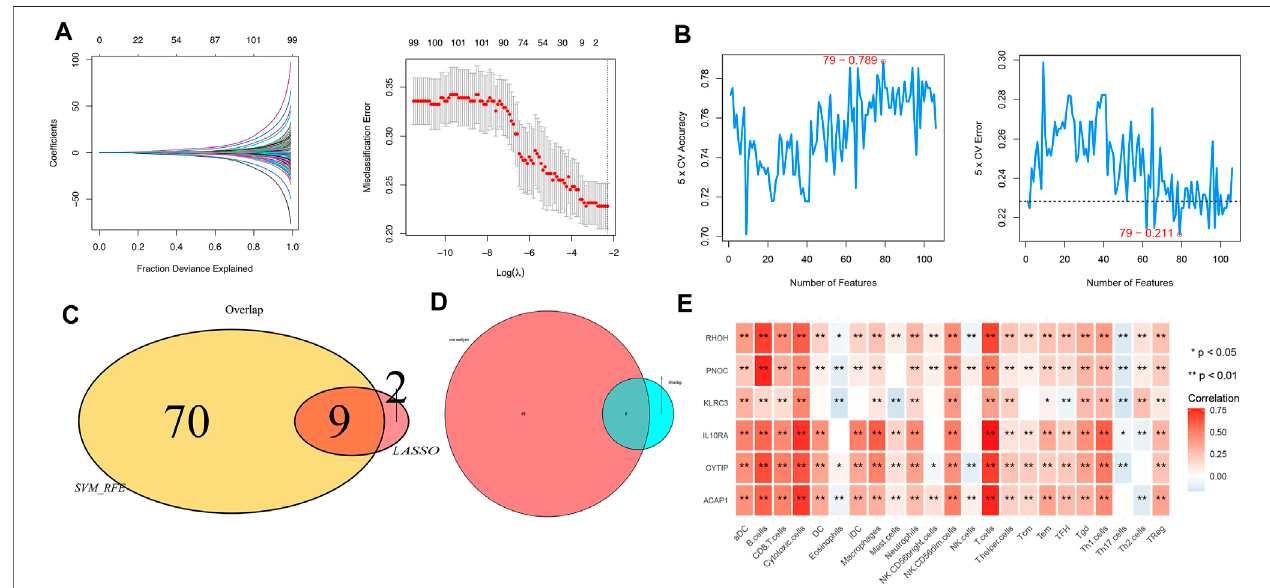
FIGURE 5 | (A) LASSO and (B) SVM-RFE algorithms in the detection cohort. (C) Overlap of incorporated genes selected from two algorithms in the detection cohort. (D) Intersection of characteristic genes with PD/RD and Cox analysis genes. (E) Correlation between immune cell in fi ltration and selected